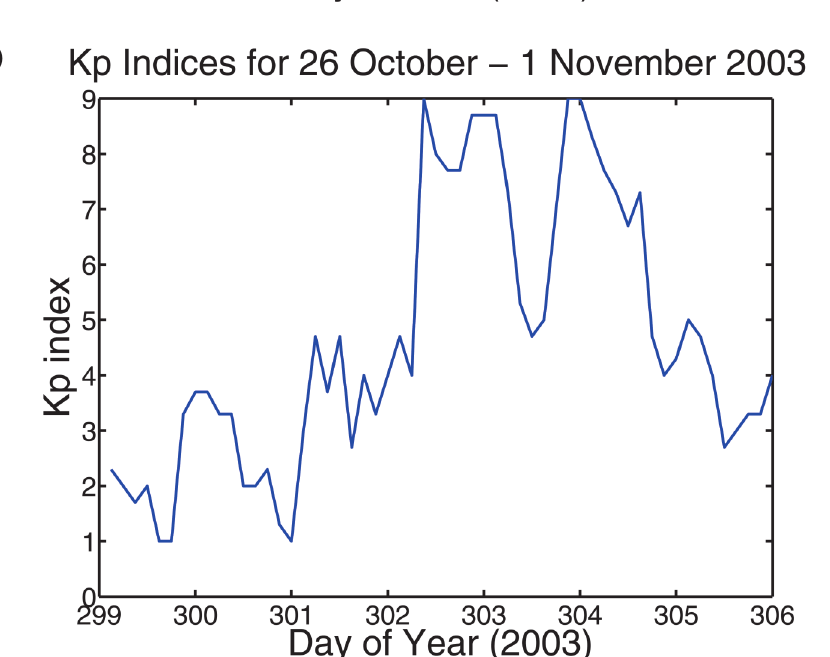
Fig. 7a,b. Receiver clock bias referenced to the receiver clock bias from CODE for VILL before, during and af- ter the October 2003 ionospheric storm, using a fixed GPS receiver solution (a) and corresponding Kp indices